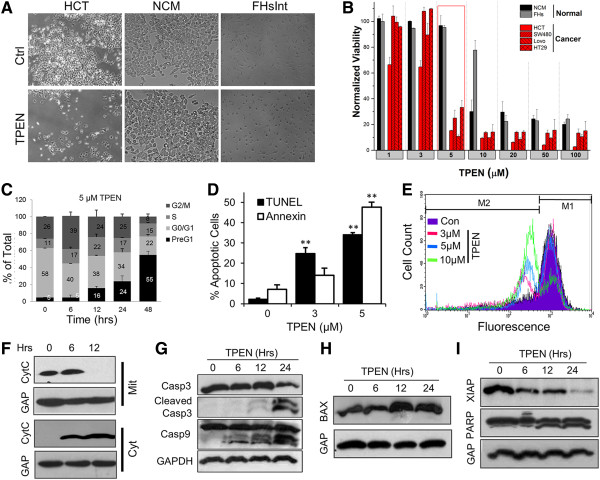
TPEN selectively kills colon cancer cells. A) Morphology of HCT116, NCM460, and FHS74Int cell lines with and without treatment with 5 μM TPEN for 24 h. B)Cell viability measured using the MTT assay as a function of TPEN concentrations in NCM 460, FHS74Int, HCT 116, SW480, LoVo and HT-29 cells (mean ± SD, n = 3). C) The mean percentage of cells in each cell cycle phase after DNA staining with PI and flow cyotmetry. D) TUNEL and Annexin assays in control cells and cells treated with TPEN 3 and 5 μM (mean ± SD, n = 3, ** p < 0.01, significant difference with respect to control). E) Rhodamine assay measuring disruption of mitochondrial membrane potential after TPEN treatment at 3, 5 and 10 μM (mean ± SD, n = 3). F) Time-dependent release of cytochrome c from mitochondria into the cytoplasm after TPEN treatment. G-I) TPEN alters the expression of several proteins involved in the apoptotic pathway in a time dependent manner. PARP, caspase-9 and caspase-3 were cleaved in response to TPEN. Bax levels were increased at 12 and 24 h of treatment.